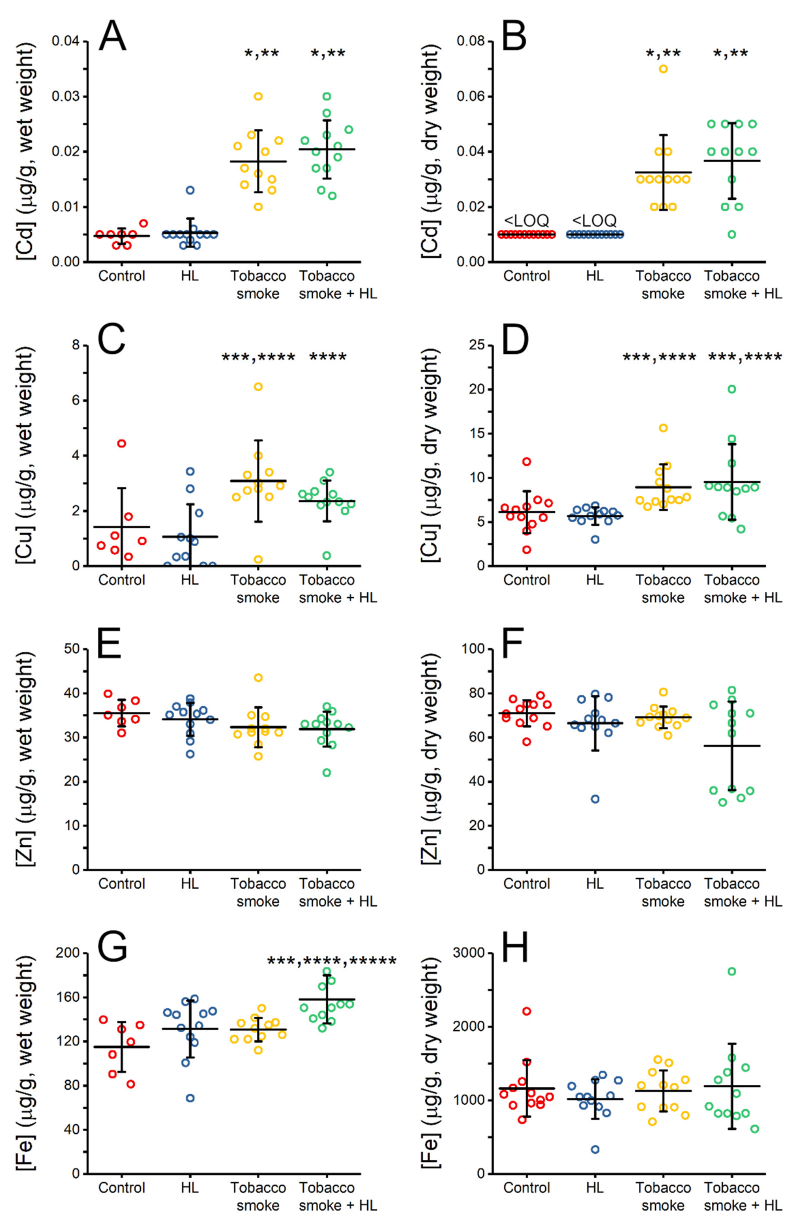
Figure 1. Influence of tobacco smoke exposure and treatment with His-Leu dipeptide (HL) on the concentrations of metals in rat lungs (µg/g), measured in wet ( A , C , E , G ) and dry ( B , D , F , H ) tissue. Shown are all measurement data (circles), mean value (horizontal line), and SD (whiskers). All values for Cd in dry tissue of the “Control” and “HL” groups were below the limit of quantitation (<LOQ; 0.01 µg/g). p -values were calculated using a two-sample t -test. * p < 0.01 vs. “Control” group, ** p < 0.01 vs. “HL” group, *** p < 0.05 vs. “Control” group, **** p < 0.05 vs. “HL” group, ***** p < 0.05 vs. “Tobacco smoke” group.